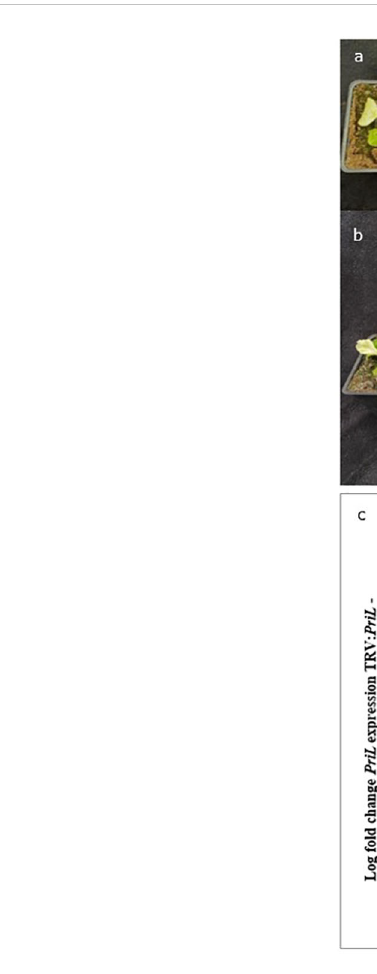
FIGURE 1 (A) . Nicotiana benthamiana plant phenotypes 14 days post in fi ltration with VIGS constructs. From left to right: TRV: Nb PDS , TRV: Nb PriL , TRV: GUS , Wild Type (WT); (B) ToLCNDV inoculated N. benthamiana plant phenotypes 10 days post inoculation. From left to right: TRV: Nb PDS , TRV: Nb PriL , TRV: GUS , Wild Type (WT). Inoculation with the geminiviruses TYLCV and BCTV led to similar phenotypes compared to ToLCNDV. (C) Average log fold PriL expression change of TRV : PriL plants, inoculated with the different viruses, compared to TRV: GUS plants. (D) Average log fold difference in viral titers between TRV: PriL and TRV: GUS plants. Signi fi cant difference between TRV : PriL and TRV : GUS (p <